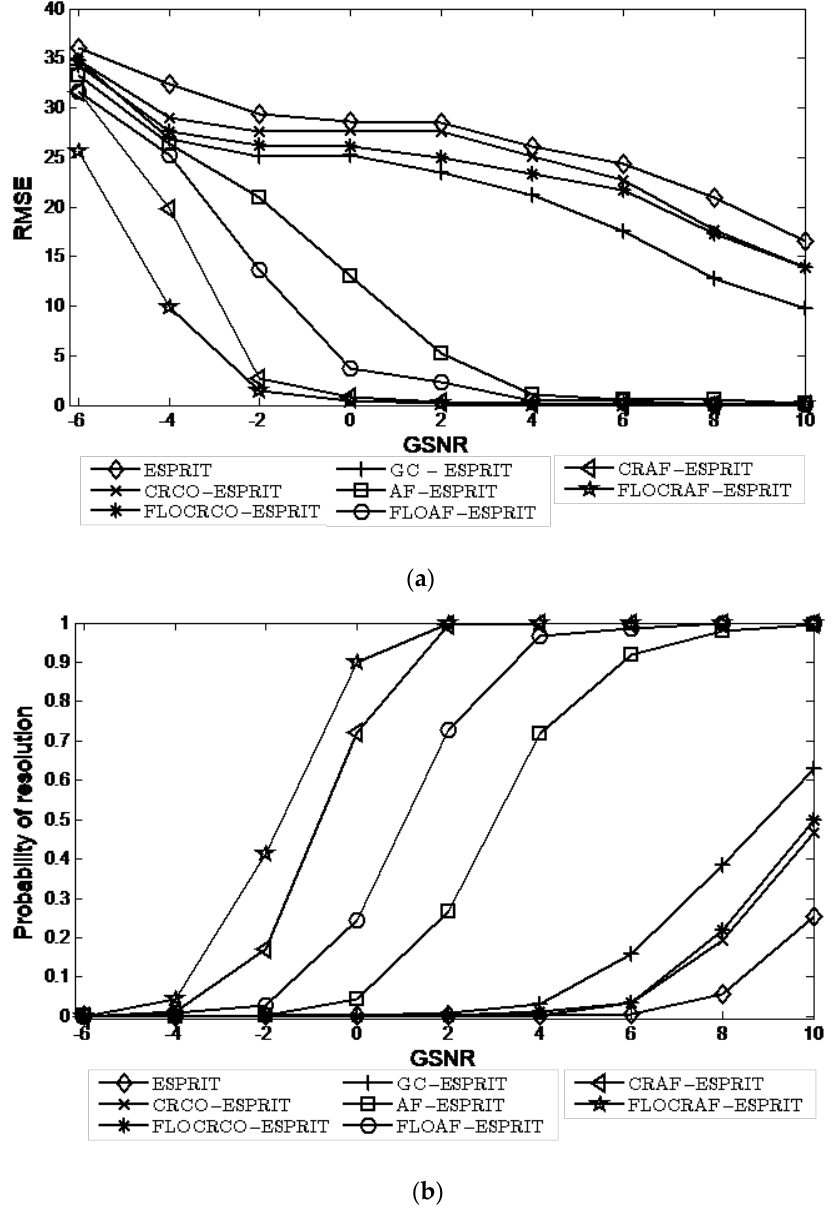
Figure 4. Performance vs GSNR ( α = 1.6 ): ( a ) RMSE; ( b ) Probability of resolution.